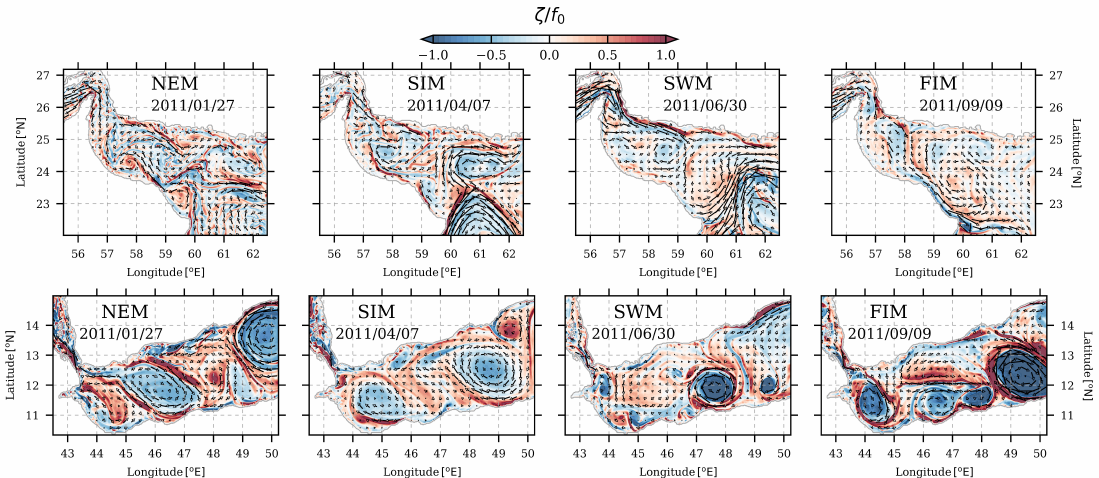
Figure 2. Snapshots of surface vertical relative vorticity normalized by the areal mean Coriolis frequency ( f 0 ), (1st row) in the Gulf of Oman, and (2nd row) in the Gulf of Aden representative of the surface dynamics during (1st column) the North-East Monsoon (NEM), (2nd column) the Spring Inter-Monsoon (SIM), (3rd column) the South-Western Monsoon (SWM), and (4st column) the Fall Inter-Monsoon (FIM). Black arrows stand for the surface velocity